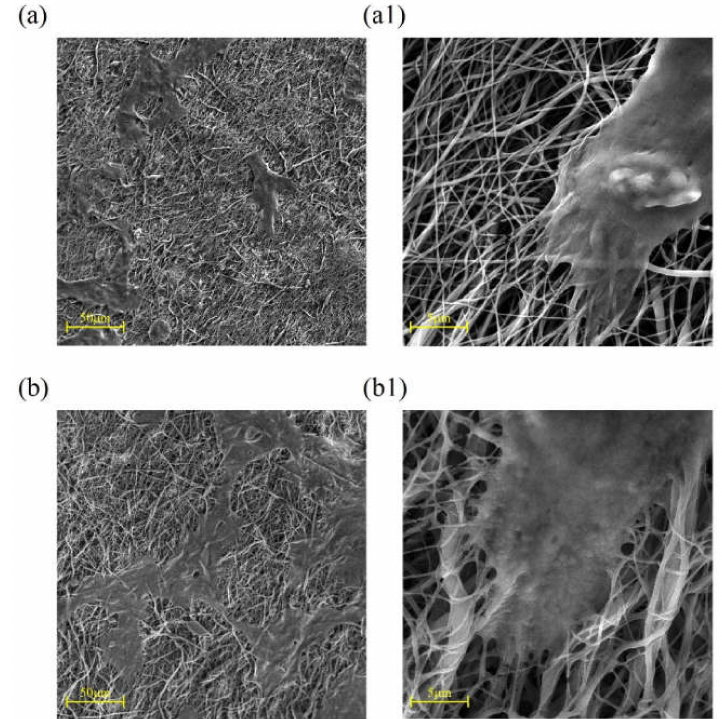
Figure 9. SEM images showing HaCaT cell line adhesion on ( a , a1 ) pristine PCL electrospun samples; ( b , b1 ) collagen / chitosan grafted specimens (cultured for 3